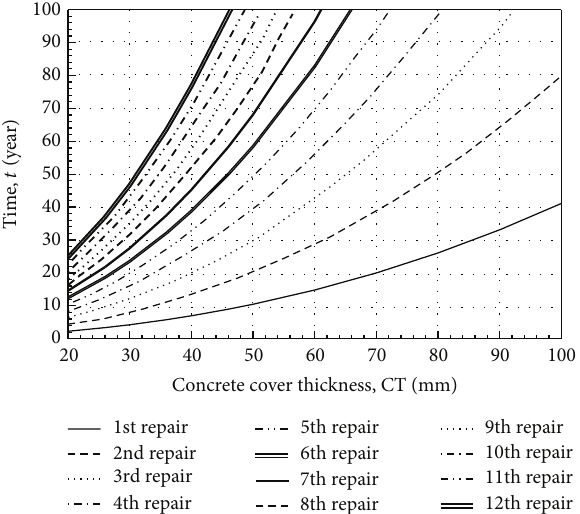
Figure 7: Effect of the concrete cover thickness on the repair sched- ule of the present concrete column.